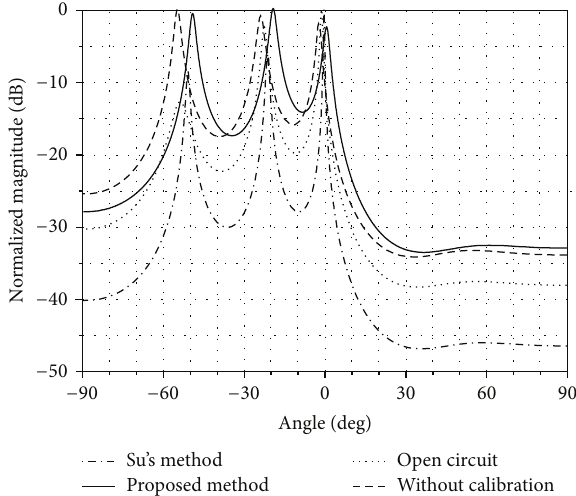
Table4:Parametersoftheincidentsignalsfor2DDOAestimations.